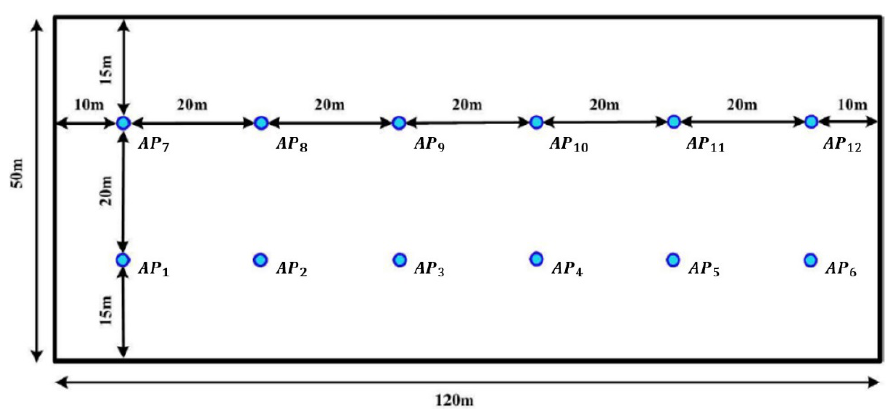
Figure 1. Indoor environment suggested by 3GPP.